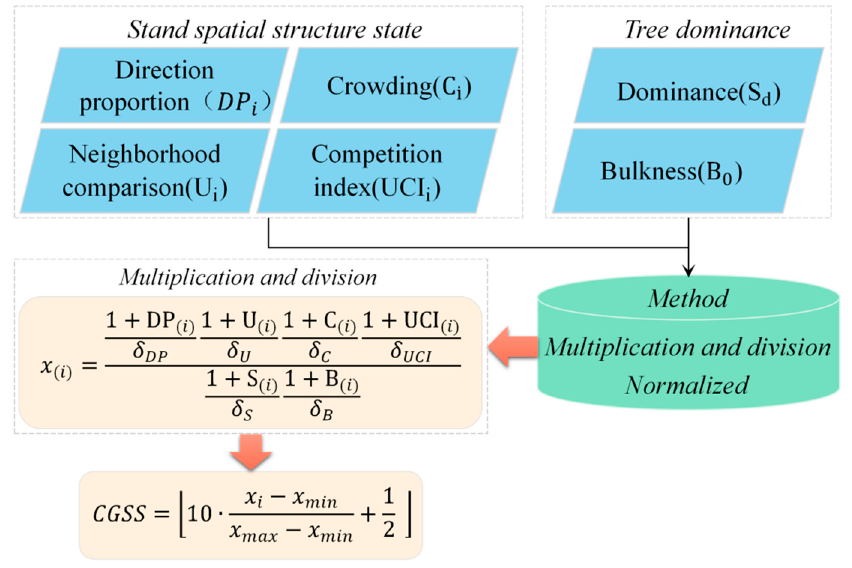
Figure 2. Schematic diagram of Adjacent trees in di ff erent orientations of the center tree. ( a , b ) Dis- tribution when the angle between any two adjacent trees is smaller than the standard angle. ( c , d ) Distribution when the angle between any two adjacent trees is greater than the standard angle. The numbers 1–4 represent the distribution of the four adjacent trees.